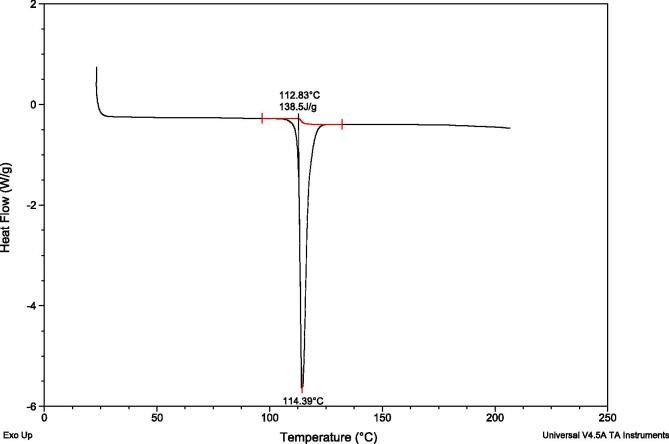
DSC analysis of 3-o-ethyl-l-ascorbic acid.